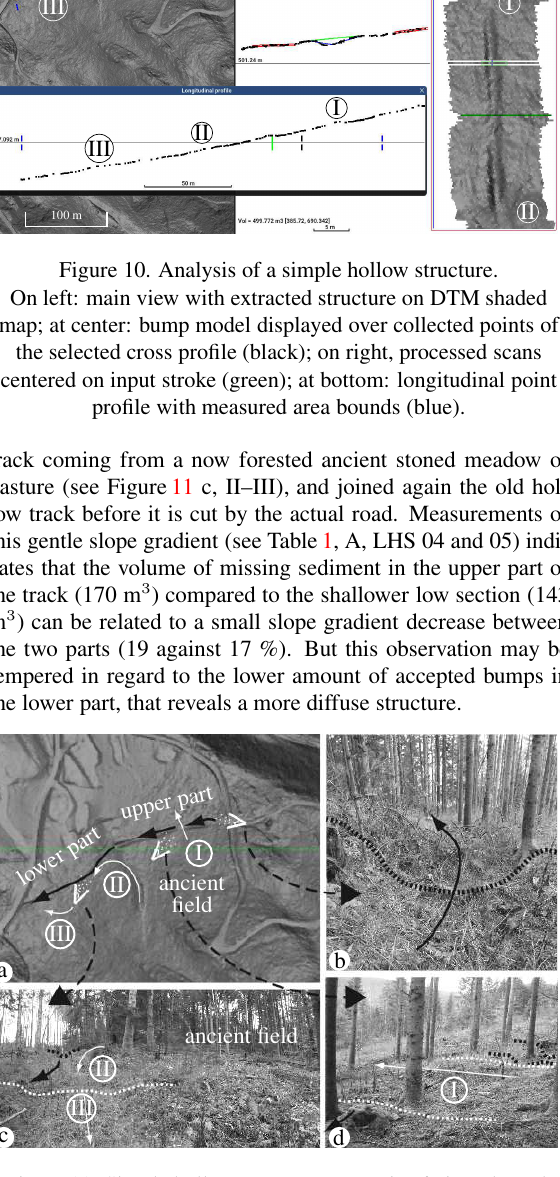
Figure 11. Simple hollow structure. : axis of views b, c, d; white arrow: recent track layout; black arrow: old track layout; white dots: recent track; black dots: old